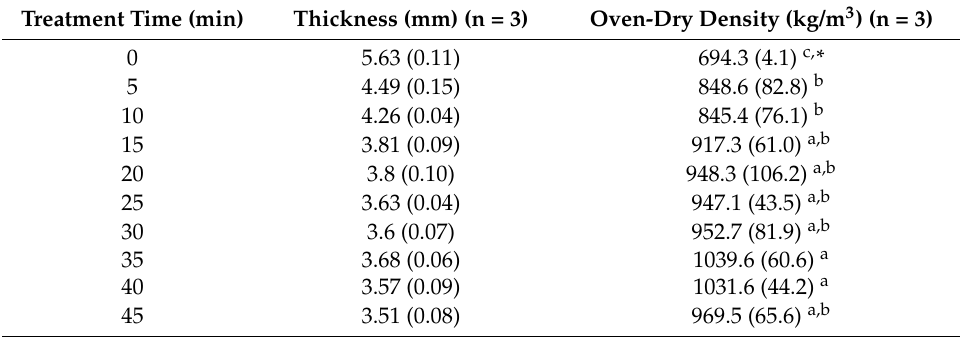
Table 2. Oven-dry density of the control and samples densified at different time.